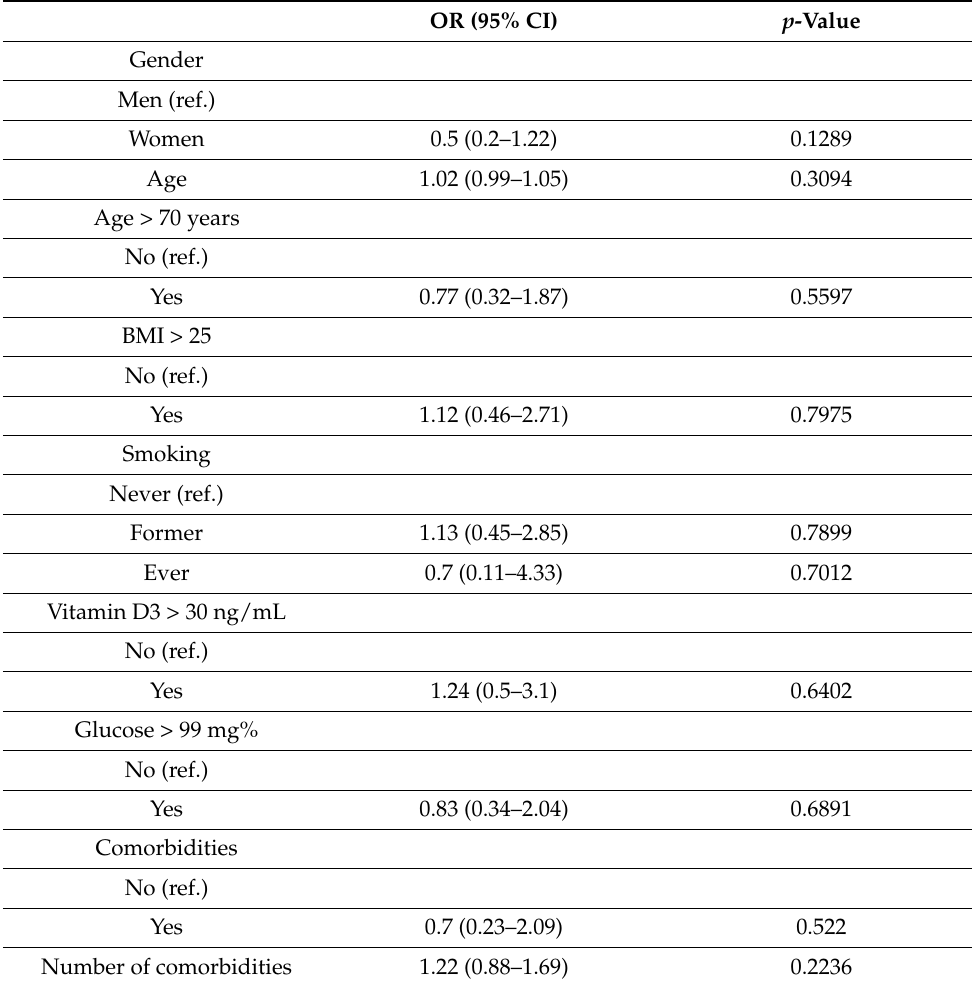
Table 3. Logistic regression analysis of the risk factors of mild to severe COVID-19 in vaccinated individuals developing